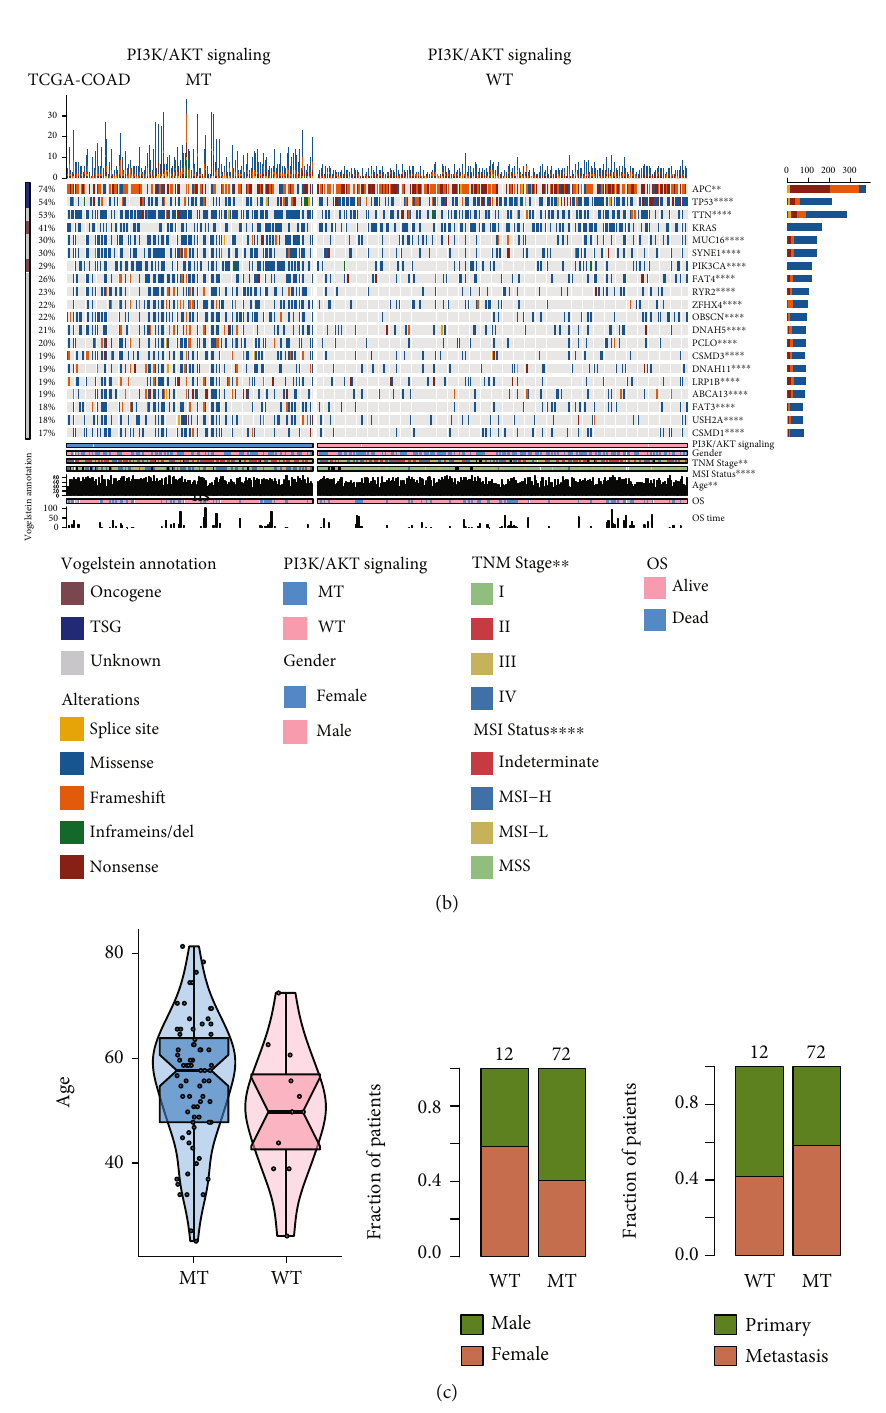
Figure 2: Gene mutation panorama of colorectal cancer patients in the immunotherapy cohort (a) and TCGA-COAD cohort (b) and the relationship between PI3K/Akt pathway mutations and clinical characteristics (c). (a) The 20 genes with the highest mutation frequencies in COAD patients in the immunotherapy cohort and their corresponding clinical characteristics are displayed. The mutation frequencies of PIK3CA, ARID1A, and PTPRS were signi fi cantly increased in the PI3K/Akt-MT group. Yellow represents cleavage site mutations, blue represents missense mutations, orange represents frame shift mutations, green represents insertion/deletion mutations, and brown represents nonsense mutations. (b) The 20 genes with the highest mutation frequencies in patients in the TCGA-COAD cohort and their corresponding clinical characteristics are displayed. With the exception of KRAS, the mutation frequencies of all other genes changed signi fi cantly. Yellow represents cleavage site mutations, blue represents missense mutations, orange represents frame shift mutations, green represents insertion/deletion mutations, and brown represents nonsense mutations. (c) Relationship between PI3K/Akt pathway mutations and clinical characteristics such as age, sex, and sample type di ff erences in the immunotherapy cohort ( ∗ P < 0 : 05 ; ∗∗ P < 0 : 01 ; ∗∗∗ P < 0 : 001 ; ∗∗∗∗ P < 0 : 0001 ; Fisher ’ s exact